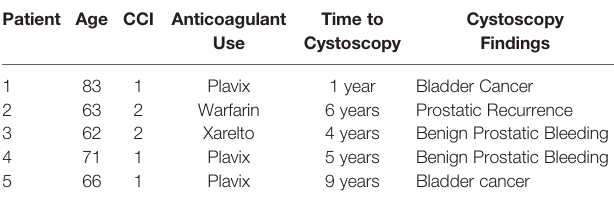
TABLE 3 | Results of cystoscopies.